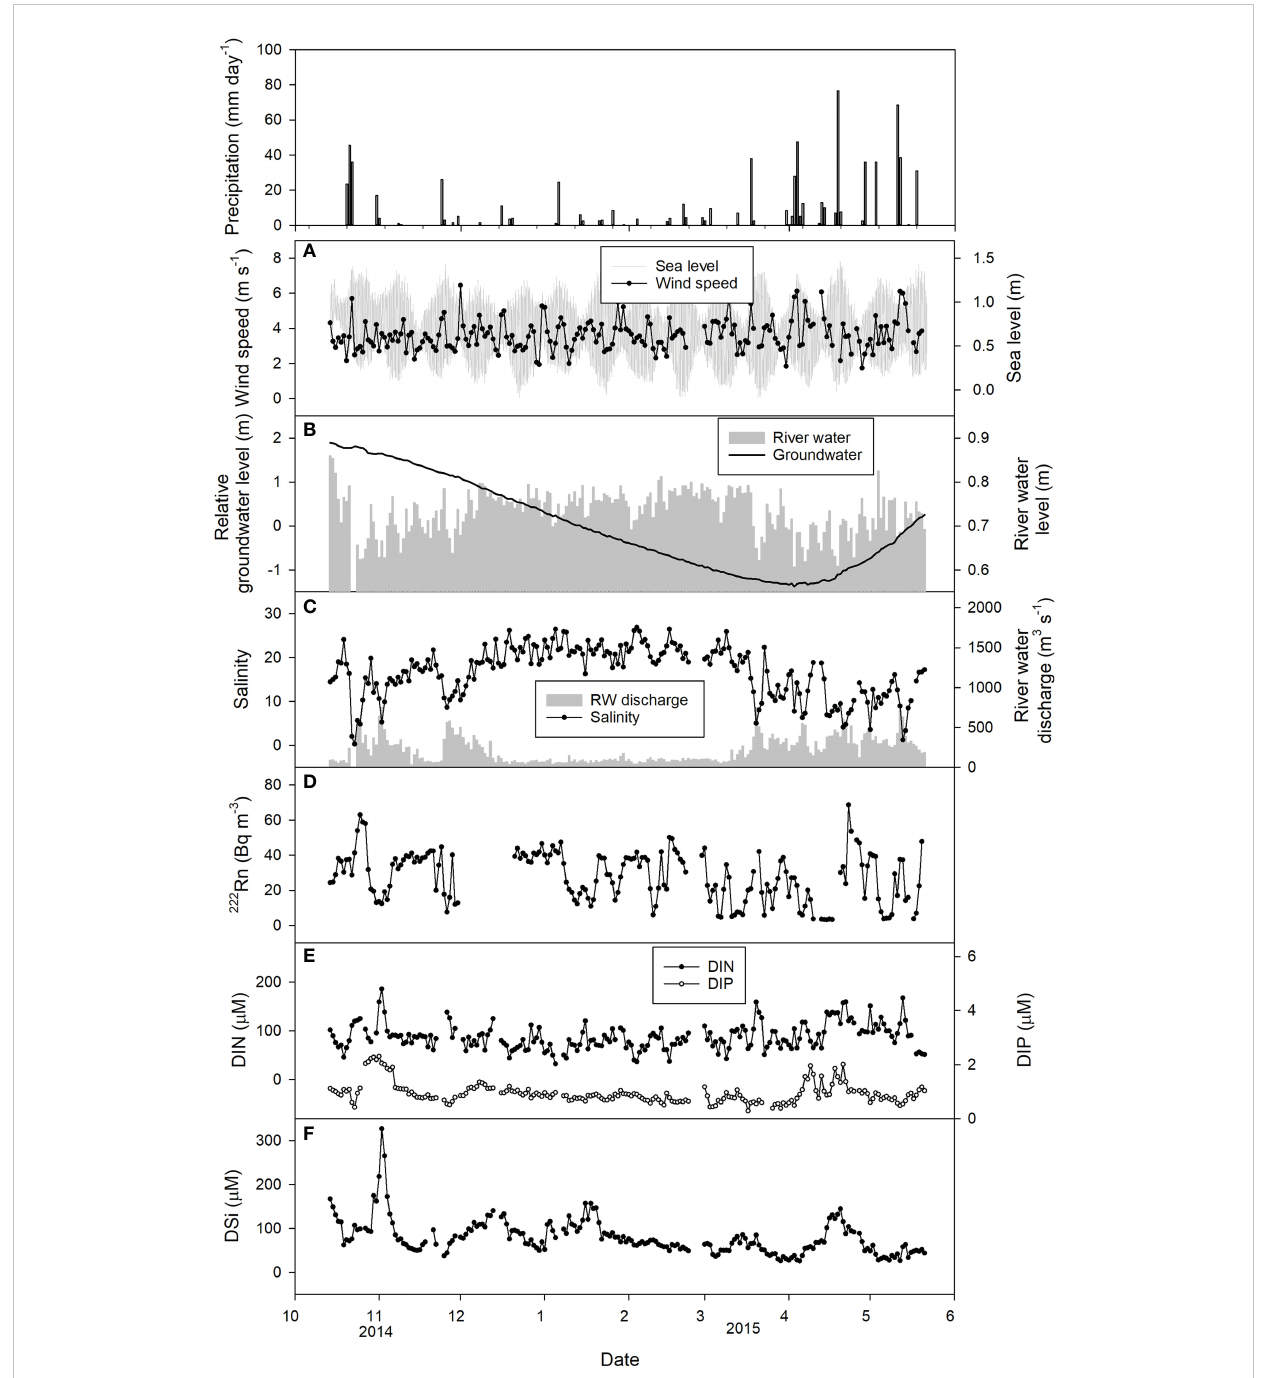
FIGURE 2 Time series measurement results of the daily averages for (A) wind speed and sea level, (B) relative groundwater level and river water level, (C) salinity and river water discharge rate, (D) 222 Rn activity, (E) DIN (closed circle) and DIP (open circle) concentrations, and (F) DSi concentration from October 2014 to May